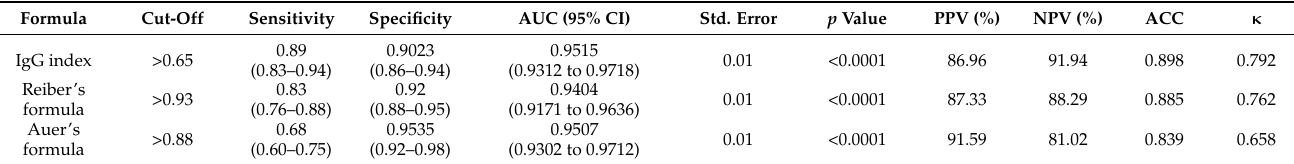
Table 3. Results of ROC analysis.